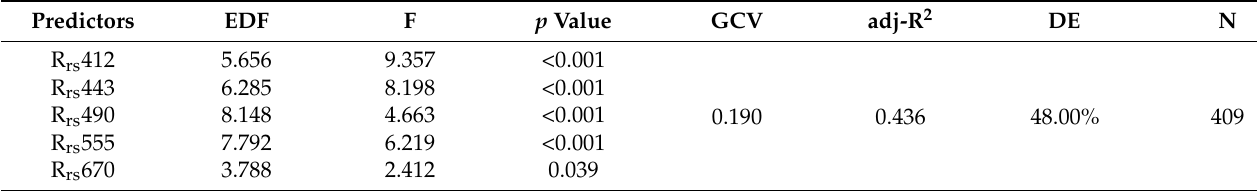
Table 11. Statistical summary of the fitted prasinophyceae GAM.